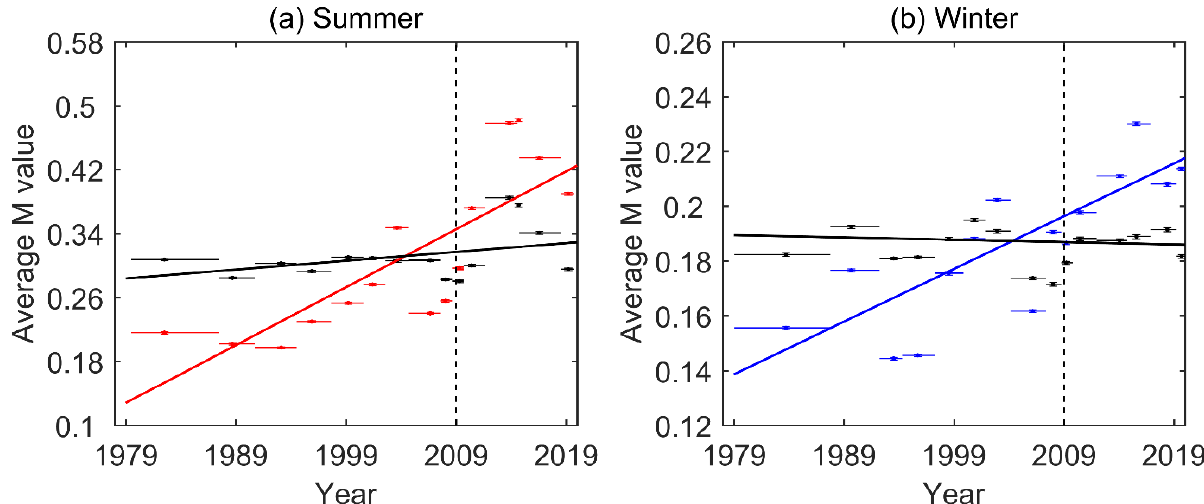
Figure 8. Multi-annual variation of M values in ( a ) summer and ( b ) winter during 1979 – 2019. The red lines in ( a ) and blue lines in ( b ) are same as those shown in Figure 4. The black lines in both panels are the multi-annual variations of M 0 values based on the null hypothesis. The fitting results in the least square sense can illustrate the effect of buoy spatial sampling on the trends derived from the IABP dataset.